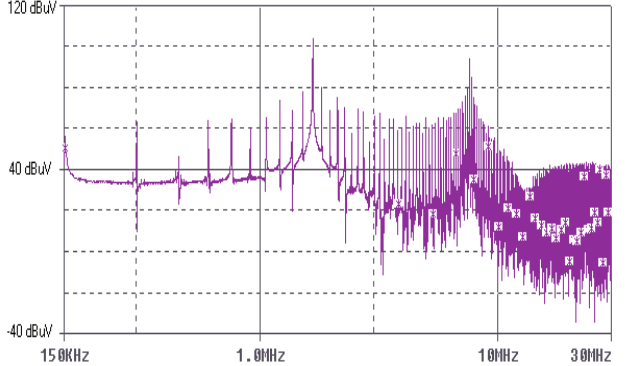
Fig. 5. Simulations of conducted EMI results from the input